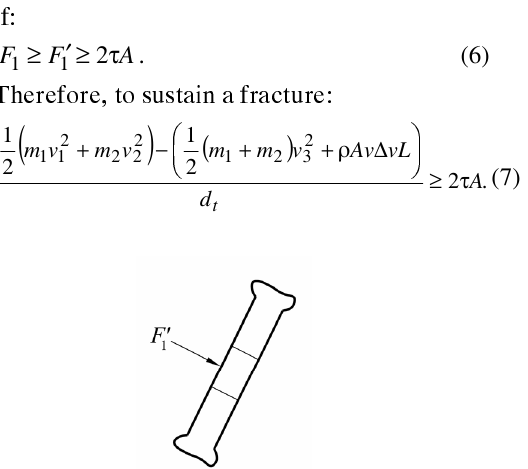
Fig 2. Transverse force acting on the